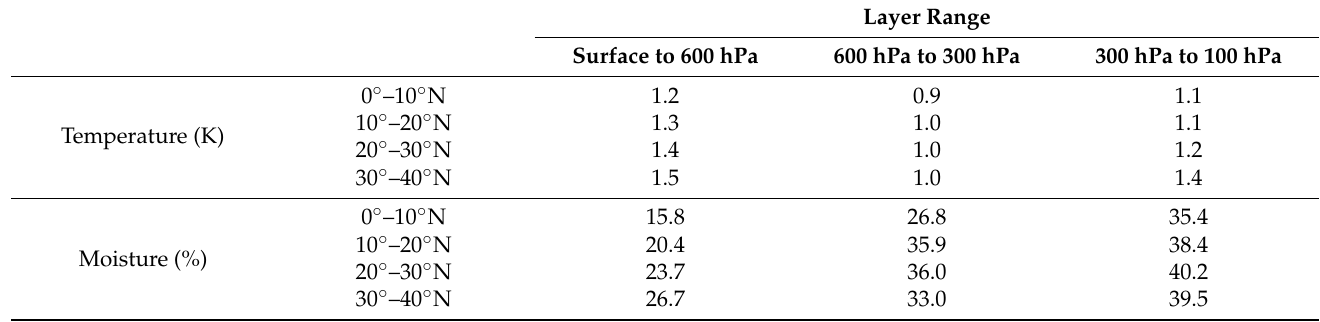
Table 4. The mean RMSE and bias of temperature and relative humidity between the retrieval results and ERA5 data in different latitudinal bands in three broad